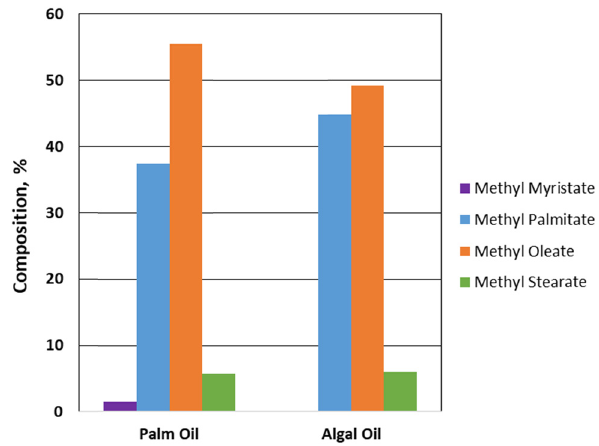
Figure 2: Major fatty acid component in palm and algal